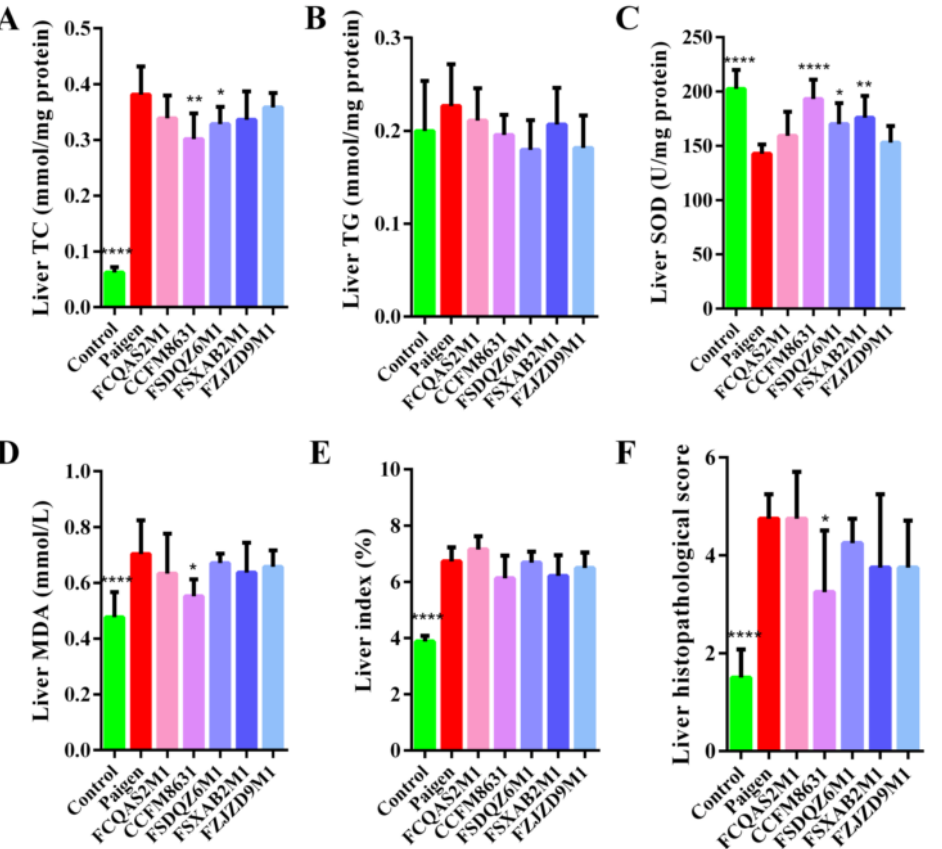
Figure 2. Analysis results of liver biochemical parameters and histopathological score. ( A ) TC. ( B ) TG. ( C ) SOD. ( D ) MDA. ( E ) Liver index (%). ( F ) Liver histopathological score. n = 8. Compared with Paigen group, * p < 0.05, ** p < 0.01, **** p <